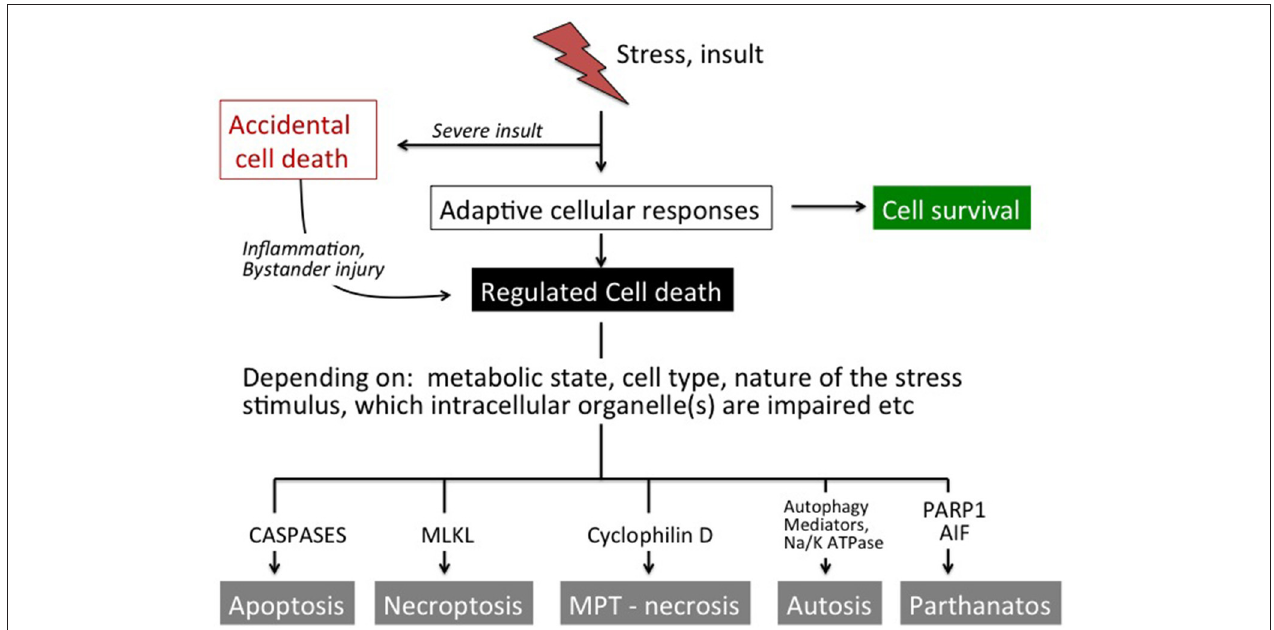
FIGURE 1 | Overview of cell death pathways. In response to mild stress stimuli a number of compensatory mechanisms will be activated most often leading to cell survival. Moderate-to-severe insults may trigger regulated cell death. Depending on several factors such as the metabolic situation, cell type, nature of the stress stimulus and which intracellular organelle(s) that are affected, the cell undergoes apoptosis (caspase activation), necroptosis (MLKL activation), necrosis (via opening of the MPT pore), autophagic cell death (autophagy/ Na + K + ATPase) or parthanatos (PARP1, AIF). Severe insults cause accidental cell death that cannot be modulated genetically or by pharmacological means. However, accidental cell death leads to the release of factors (DAMPs) that initiate systemic effects as well as inflammation and (regulated) secondary brain injury in neighboring tissue.